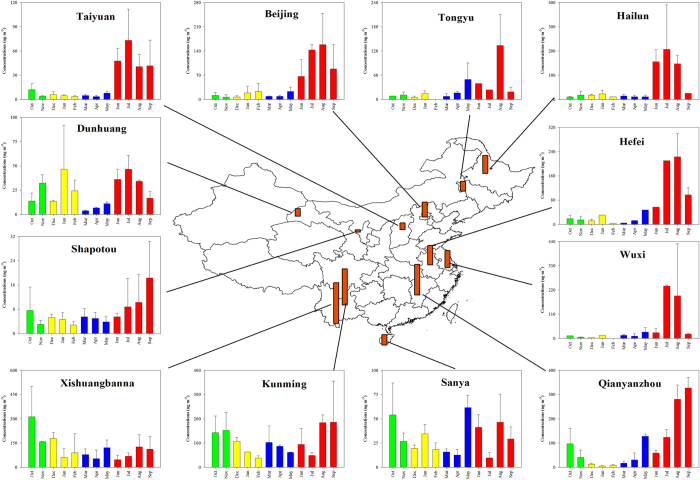
Spatial and seasonal variations of SOAI tracers in China.The orange bar in the central figure represents the annual average at each site. The green, yellow, blue and red bars represent fall (October-November, 2012), winter (December 2012-February 2013), spring (March-May 2013), and summer (June-September, 2013), respectively. The figure is created by combining ArcGIS 10.1 and SigmaPlot 10.0.